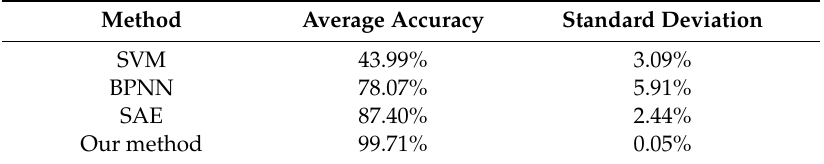
Table 2. Experimental results of average accuracy and standard deviation of various